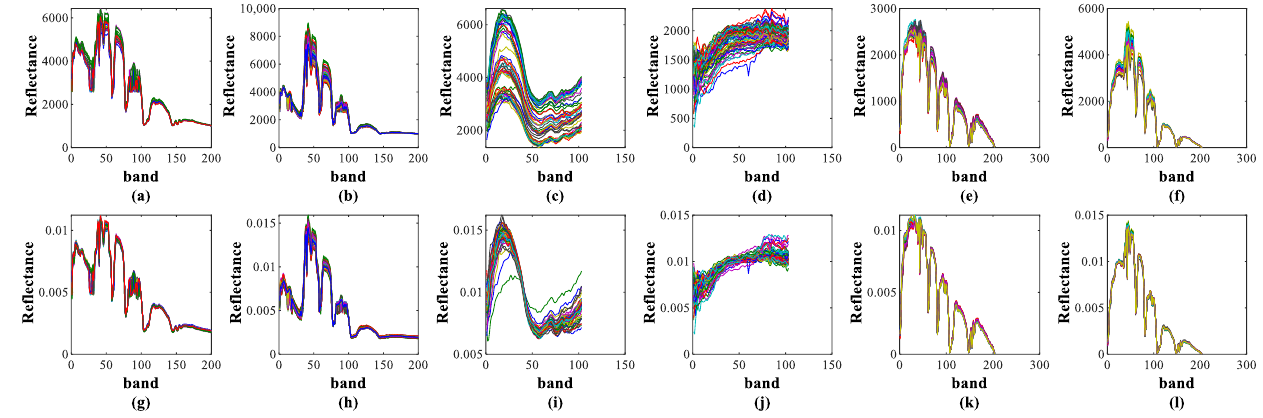
Figure 8. Original spectral curves: ( a ) Hay-windrowed and ( b ) Woods for Indian Pines, ( c ) Painted metal sheets and ( d ) Self-Blocking Bricks for Pavia University, and ( e ) Fallow and ( f ) Stubble for Salinas; and pretreated spectral curves with AN: ( g ) Hay-windrowed and ( h ) Woods for Indian Pines, ( i ) Painted metal sheets and ( j ) Self-Blocking Bricks for Pavia University, and ( k ) Fallow and ( l ) Stubble for Salinas.